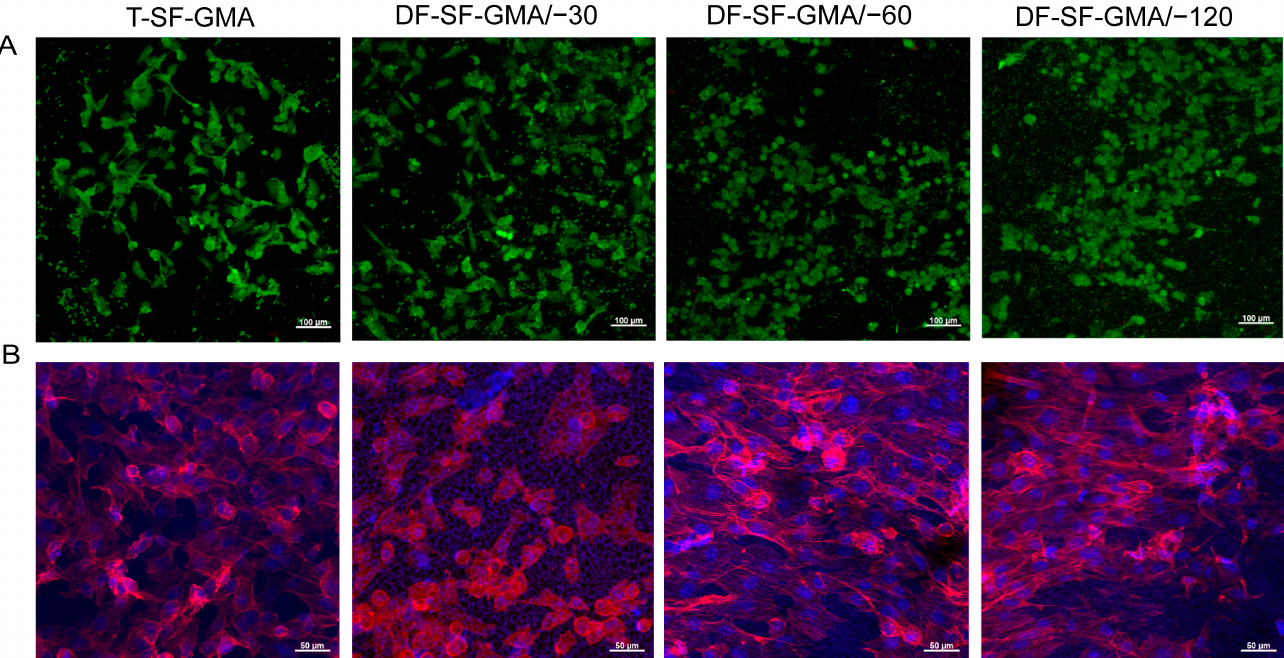
Figure 7. Cytocompatibility of the SF-GMA hydrogels. ( A ) Live/dead staining (Green: live cells; red: dead cells) and ( B ) F-actin staining (Blue: nucleus; red: F-actin) of cells cultured in the T-SF-GMA and DF-SF-GMA hydrogels for 3 days. All the cells exhibit excellent viabilities, and the cells cultured on the DF-SF-GMA/ − 60 and DF-SF-GMA/ − 120 hydrogels are aligned due to the surface morphology.